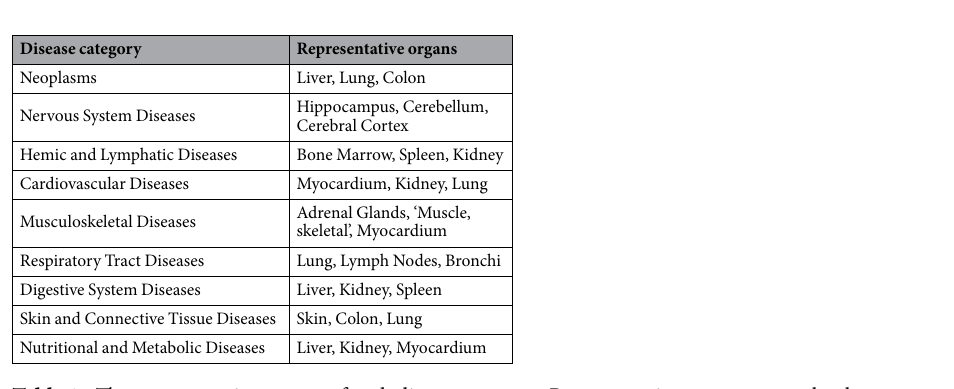
Table 1. The representative organs of each disease category. Representative organs mean the three most commonly assigned anatomical contexts for the diseases in the